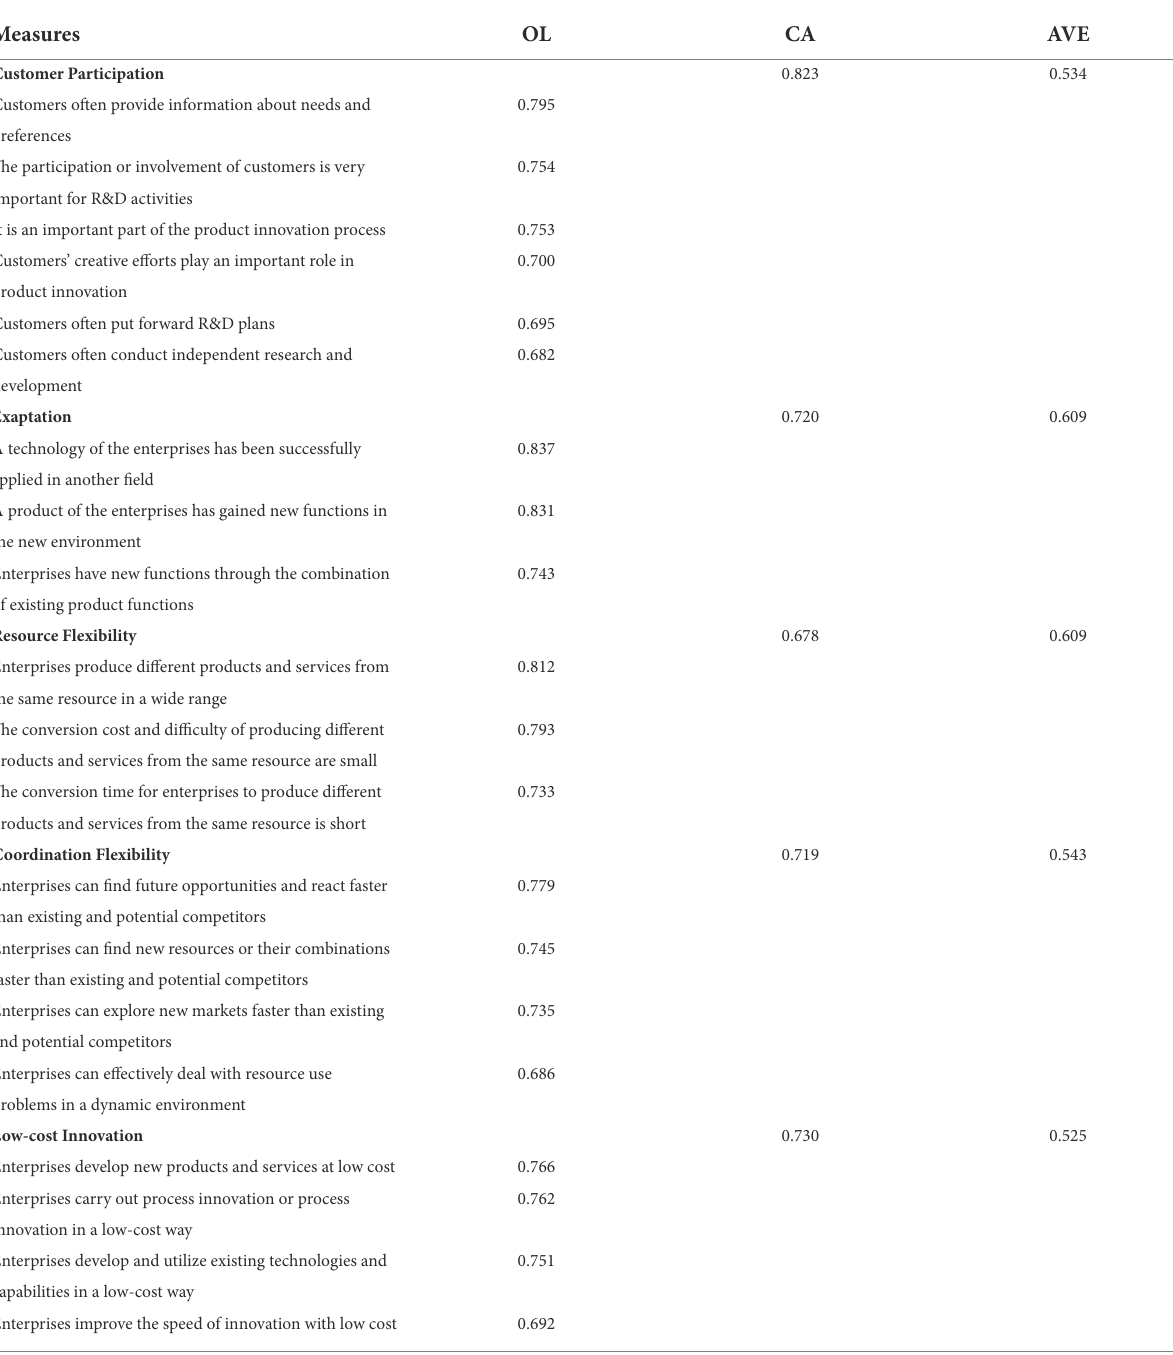
TABLE 1 Measure reliability and convergent